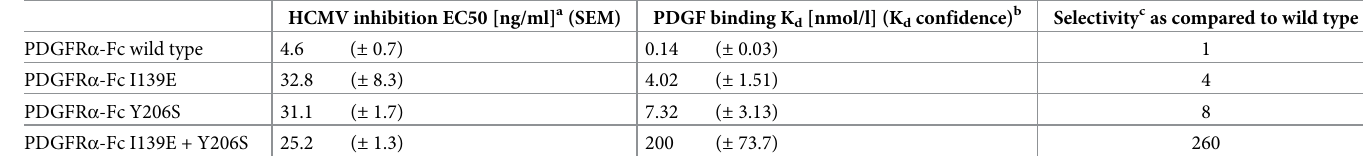
Table 2. Comparison of PDGFR α -Fc wild type and mutants regarding HCMV inhibition, PDGF affinity and the resulting selectivity. HCMV inhibition EC50 [ng/ml] a (SEM)